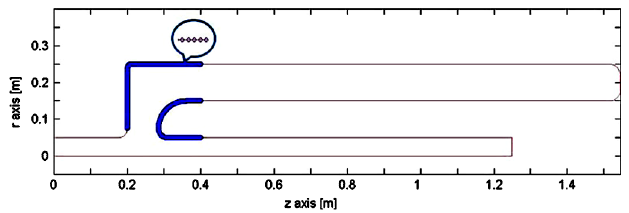
FIG. 5. (Color) Initial electron generation points between 20– 40 cm highlighted by blue